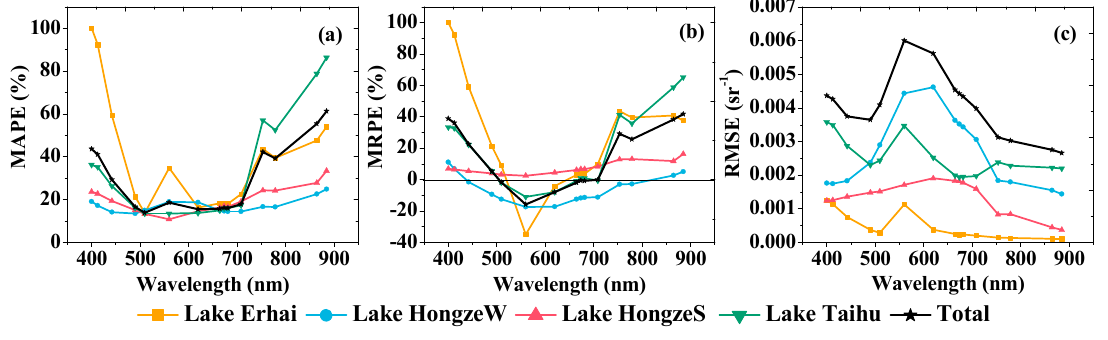
Figure 8. Comparison of the MAPE ( a ), MRPE ( b ), and RMSE ( c ) values between derived and measured R rs data in different lakes. The bold black line represents the total deviation results in all bands. The X-axis represents the wavelength range.